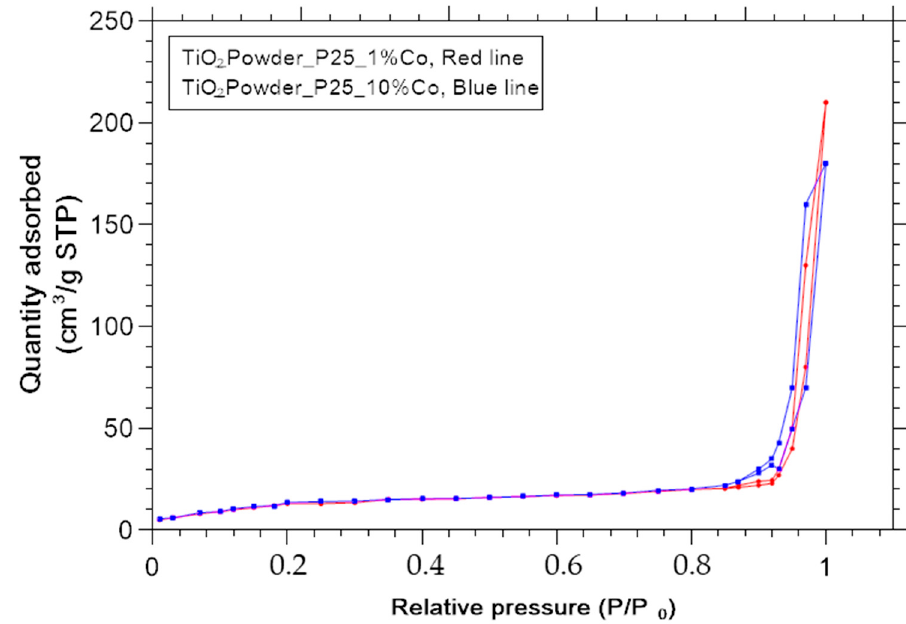
Figure 9. Adsorption branches of N2-Adsorption measurements at 77K.